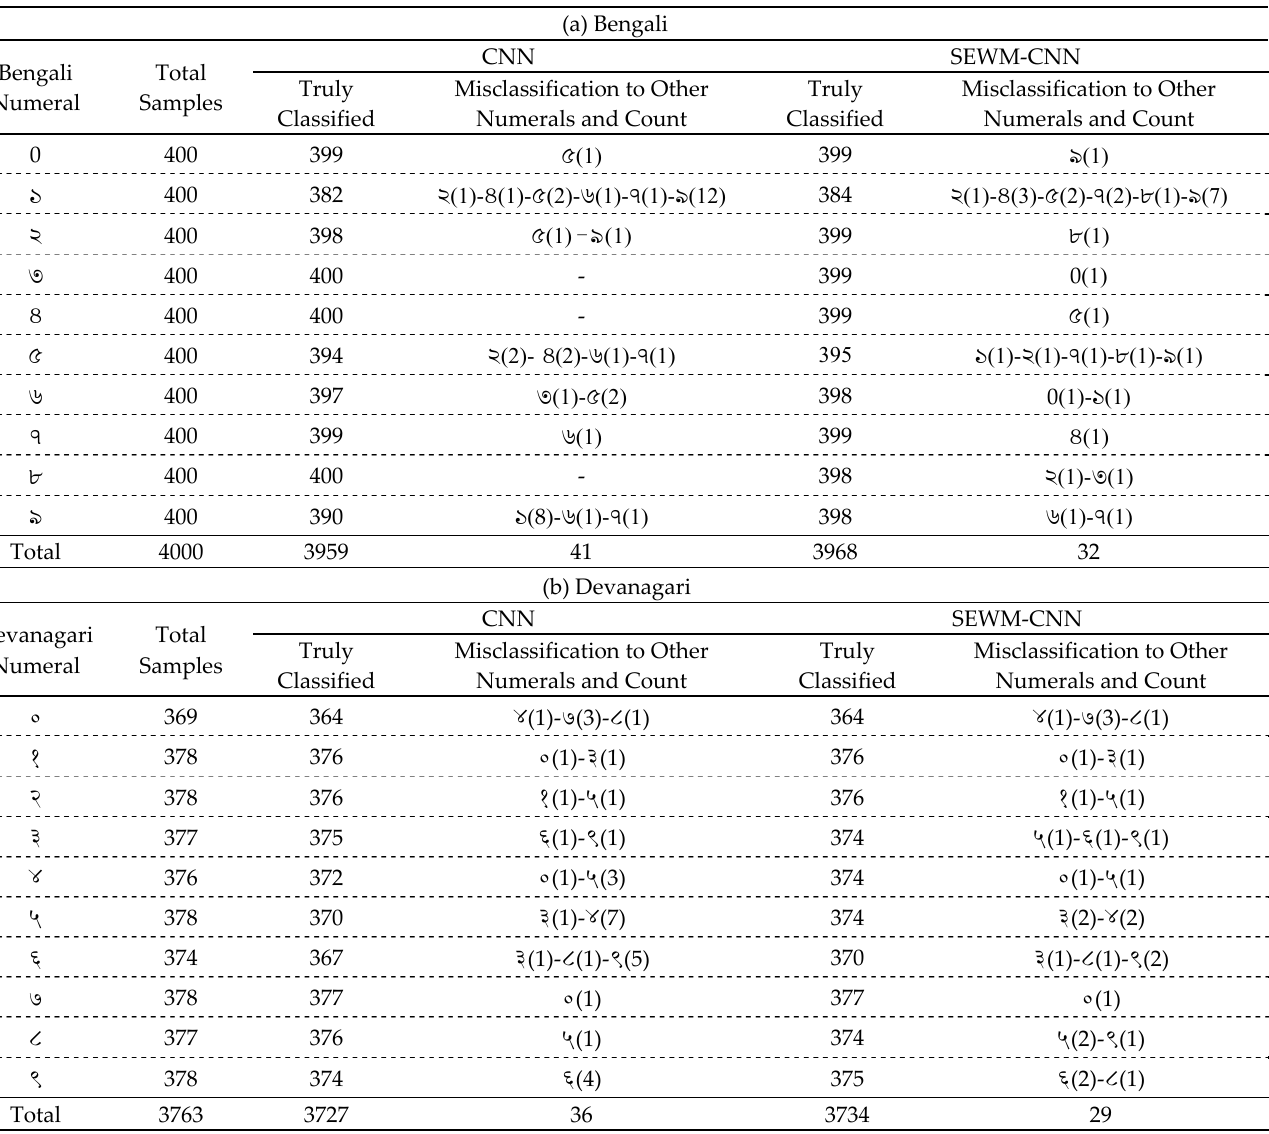
Table 3. Individual numeral‑wise performance of CNN and proposed SEWM‑CNN on test samples.